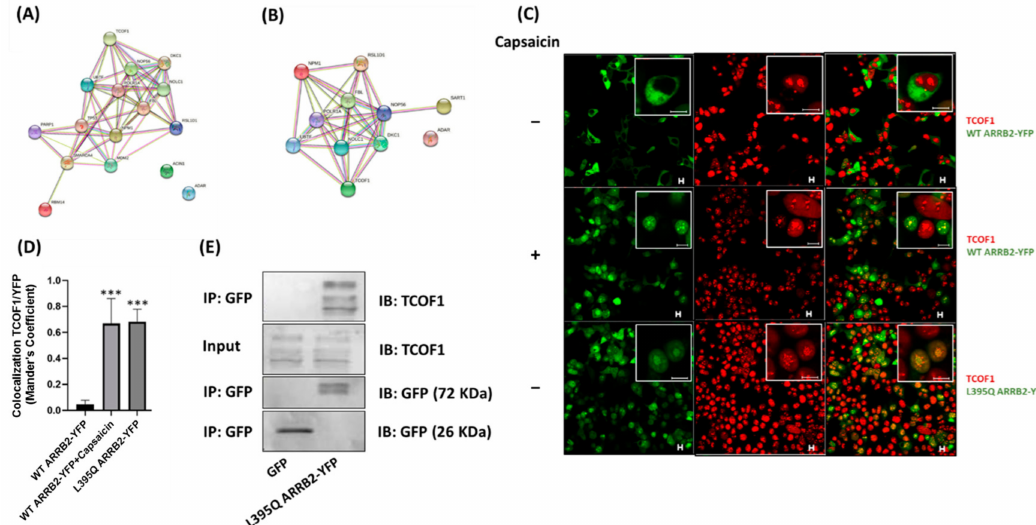
Figure 3. ARRB2 interacts with proteins involved in ribosomal biogenesis. ( A ) Proteins found to be enriched in L395Q ARRB2-YFP immunoprecipitated complexes were mapped against Homo Sapiens database using the STRING v11. The circles represent proteins, and the colored straight lines represent the type of evidence of protein–protein interactions; experimentally determined interactions (pink), text mining (yellow), protein homology (purple) gene neighborhood (green), co-expression (black), gene fusions (red), co-occurrence (blue), known interactions (teal). STRING analysis revealed a cluster of proteins that are components of the nucleolus. ( B ) Analysis identified a subset of the nucleolar proteins that are involved in ribonucleoprotein complex biogenesis. ( C ) Representative confocal image of colocalization between TCOF1 (red) and ARRB2 (green) in HEK293 cells transfected with plasmids expressing TRPV1 and ARRB2–YFP or the L395Q ARRB2-YFP mutant, without or with 1 µ M of capsaicin for 15 min. Scale bars, 10 µ m. ( D ) Quantification of the colocalization between TCOF1 and YFP using the Mander’s coefficient in ImageJ. Note that TCOF1 is colocalized with L395Q ARRB2-YFP mutant or WT ARRB2-YFP, after capsaicin treatment. Sample means are plotted ± SEM. Statistical analyses were performed using Kruskal–Wallis test; *** p < 0.001. ( E ) Co-immunoprecipitation analysis between TCOF1 and L395Q ARRB2-YFP or green fluorescent protein (GFP) control. Immunoprecipitates from transfected HEK293 cells were immunoblotted for TCOF1 (upper panel), input membrane immunoblotted (IB) with antibody to GFP which recognizes GFP and YFP. Molecular masses in kDa are indicated on the right. Immunoprecipitation is representative of three independent experiments. Statistical analyses were performed using Kruskal–Wallis test; *** p <